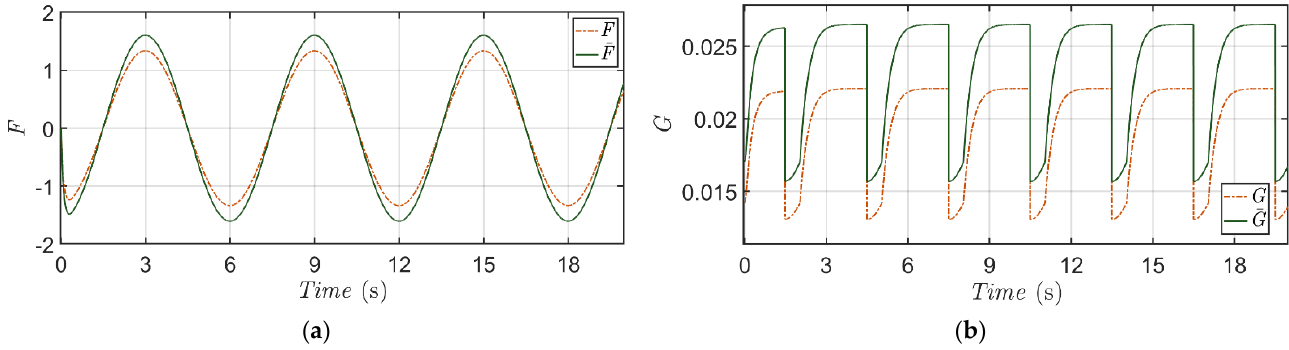
Figure 13. Comparisons of model functions F and G (green line) with F and G (red dotted line) in Scenario 2. ( a ) F and F , ( b ) G and G .